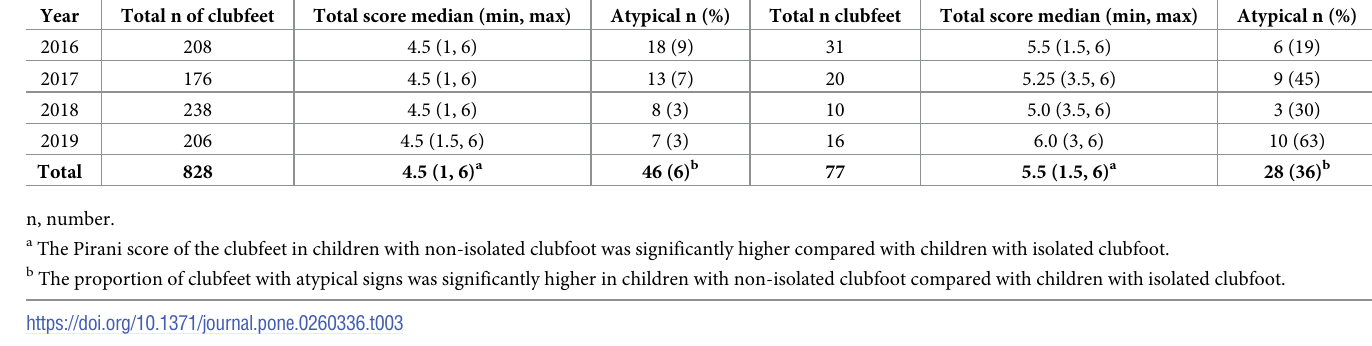
The clubfeet (n = 828) in children with isolated clubfoot had a median Pirani score of 4.5 (range 1–6). The Pirani score in children with non-isolated clubfoot (n = 77) was significantly higher (median 5.5, range 1–6) ( P < 0.001; Table 3, Fig 1). Of the 828 isolated clubfeet, 6% (46 feet) were classified as atypical at birth. A statistically significantly higher proportion of the 77 non-isolated clubfeet, 36% (28 feet), was classified as atypical at birth (mean diff. 0.31 (95% CI 0.25–0.37) (Table 3). Time to first contact with pediatric orthopedic department. The median time between birth and clubfoot diagnosis by a pediatric orthopedic surgeon was 10 days (range 0 – 186 days)